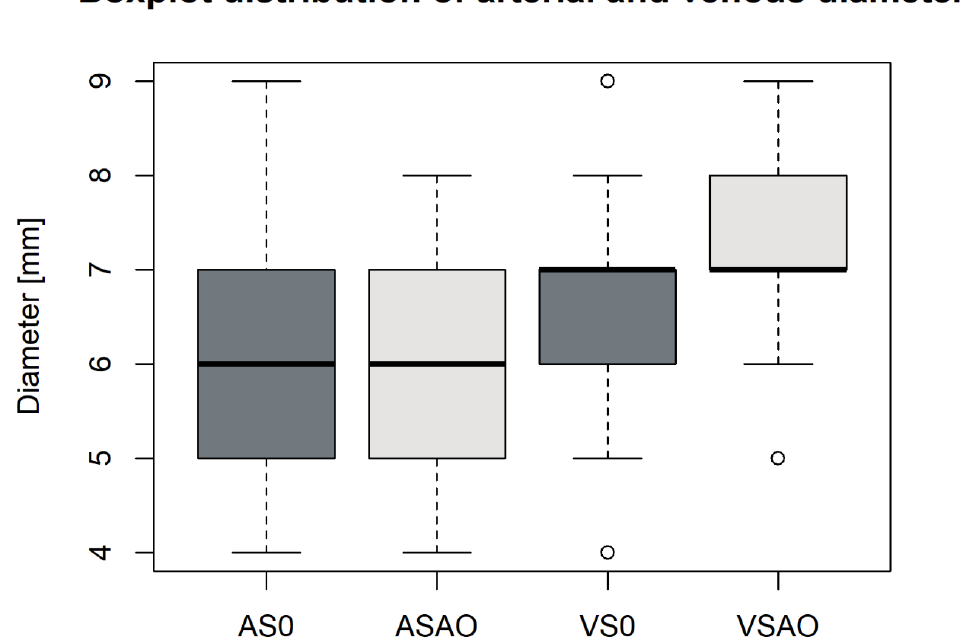
Figure 2. Boxplot distribution of arterial and venous diamters. Plots represent vascular diameters measured in A6 and V6 and classified according to the presence of COVID-19 pneumonia (AO) in the same lung segment. Venous diameters were significantly higher in diseased segments ( p = 0.031). AO, alveolar opacity; AS0, arterial diameter in segments without alveolar opacity; ASAO, arterial diameter in segments with alveolar opacity; VS0, venous diameter in segments without alveolar opacity; and VSAO, venous diameter in segments with alveolar opacity.